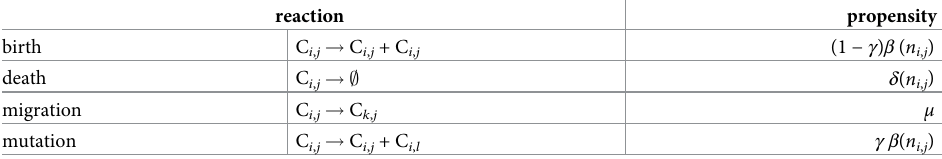
Table 1. Model system reactions. The model system evolves through four possible reactions, according to their per cell propensities. C i , j denotes an individual cell of phenotype j in patch i . Birth rate β and death rate δ are functions of total cell population